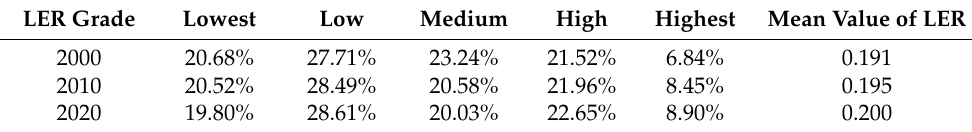
Table 5. LER-level area scale and mean value in the TGRR from 2000 to 2020. LER Grade